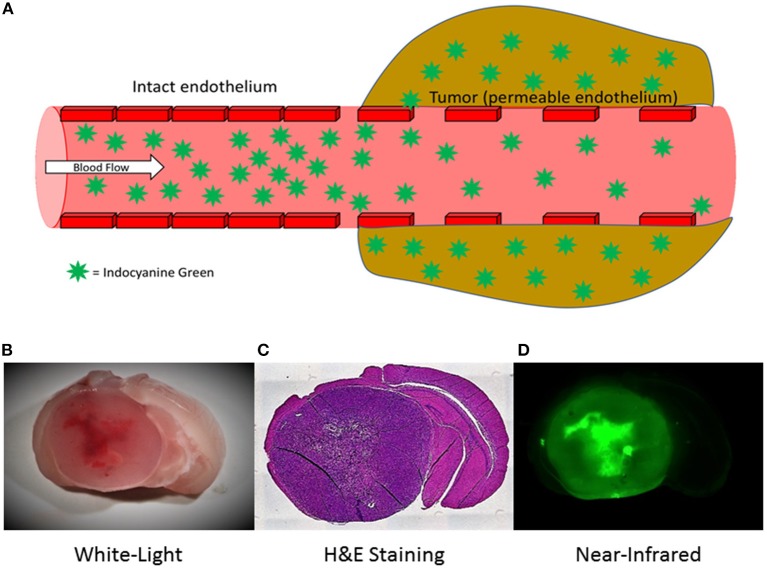
Mechanism of action for Second Window Indocyanine Green (SWIG) (A) ICG is hypothesized to accumulate in neoplastic areas via the enhanced permeability and retention effect. In areas of normal brain, with intact endothelium, the ICG remains intravascular and washes away quickly. In areas of tumor, which often have permeable/damaged endothelium, the ICG permeates into the peritumoral tissue and remains in the tissue for a prolonged time (54). (B–D) SWIG in murine model of GBM (U87 cells). Under white-light alone (B), it is difficult to visualize the full extent of the tumor, which is demonstrated by hematoxylin and eosin (H&E) staining (C). With SWIG (D), however, both the core of the tumor and the margin are delineated under near-infrared fluorescence.